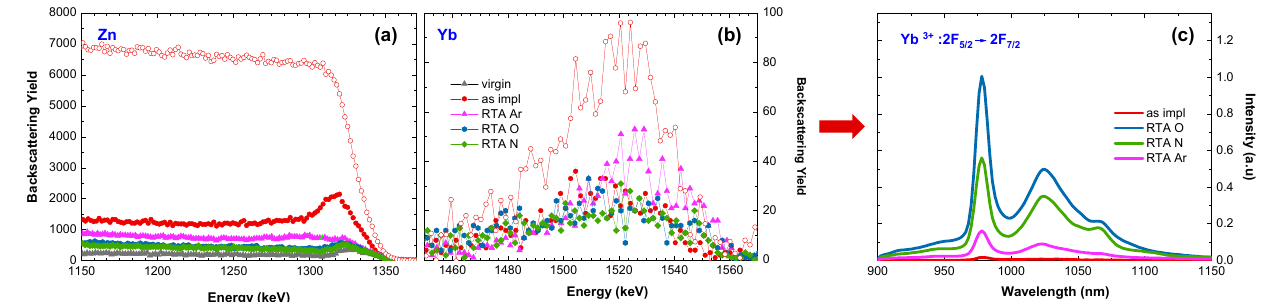
Figure 6. Random (open symbols) and aligned (solid symbols) RBS spectra ( a , b ) obtained for ZnO implanted at RT with 150 keV Yb ions to the fluence 5 × 10 14 /cm 2 and subsequently RTA-annealed